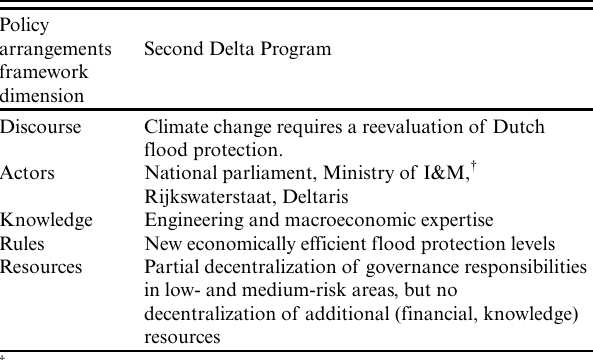
Table 4 . Changes in the Dutch policy arrangement brought about by the Second Delta